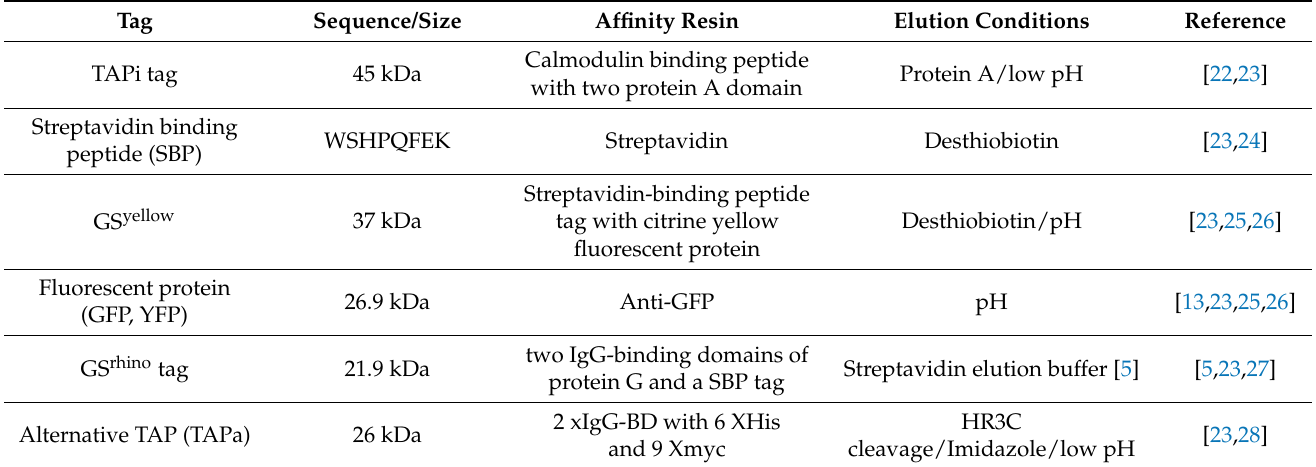
Table 1. Affinity tags successfully used to investigate plant protein–protein